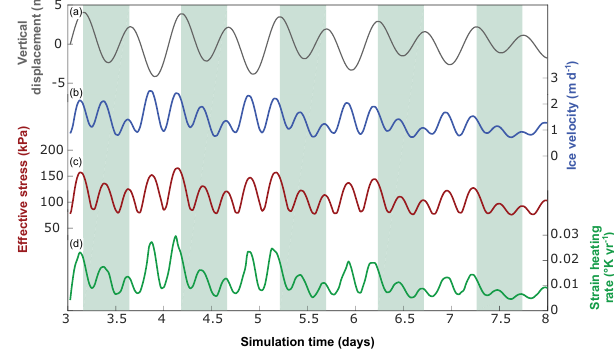
Figure 6. Time series of vertical ice displacement at the medial line (a) , ice velocity (b) , depth-averaged effective stress in the shear margin (d) and depth-averaged strain heating rate in the shear mar- gin (e) from the 3-D viscoelastic model. All variables are taken 100km downstream from the main GL. The alternating blue and white shaded areas each represent one full tidal cycle, starting and ending at high